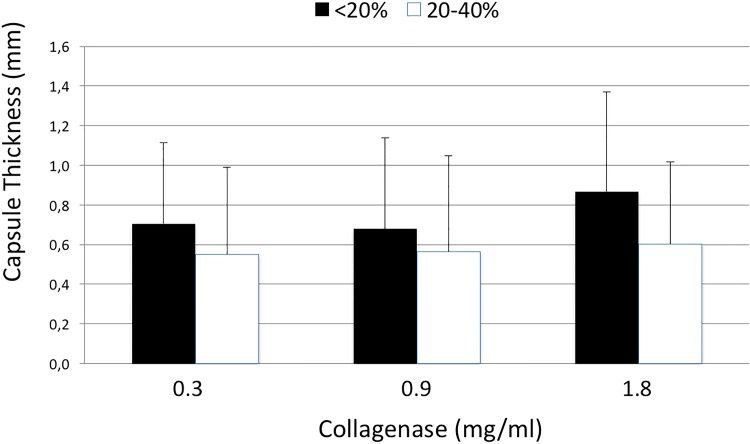
Thickness of capsule contracture tissue samples (y-axis, mm) after incubation with different doses of collagenase (x-axis, mg/ml) in correlation to capsule density (<20%, black and 20–40%, white).